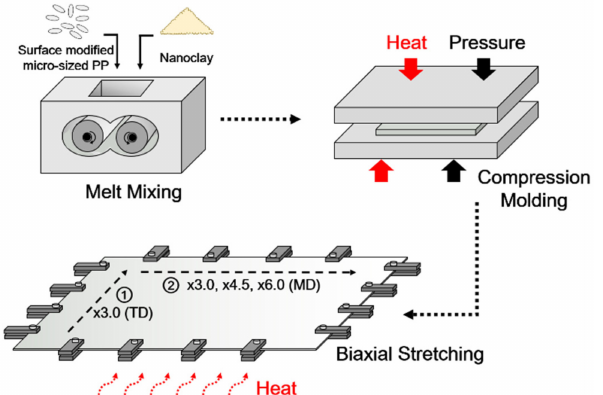
Figure 1. Schematic illustration of biaxially stretched PP/nanoclay nanocomposite film